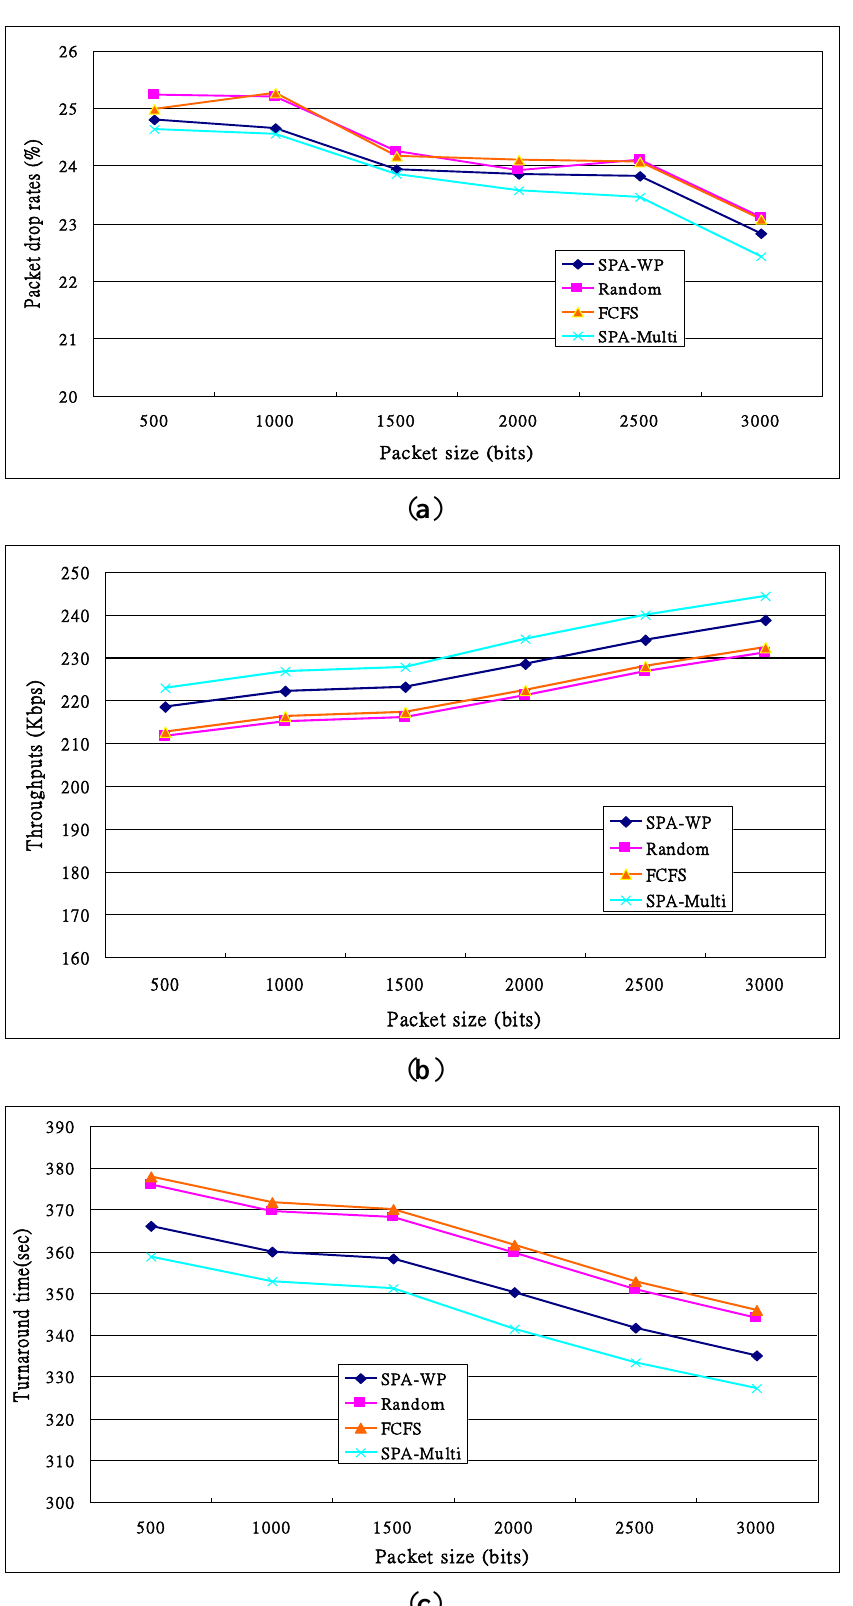
Figure 11. Performance of the second experiment given different packet sizes. ( a ) Drop rates measured at the Resource Broker; ( b ) Throughputs measured at the Resource Broker; ( c ) Turnaround times measured at the Resource